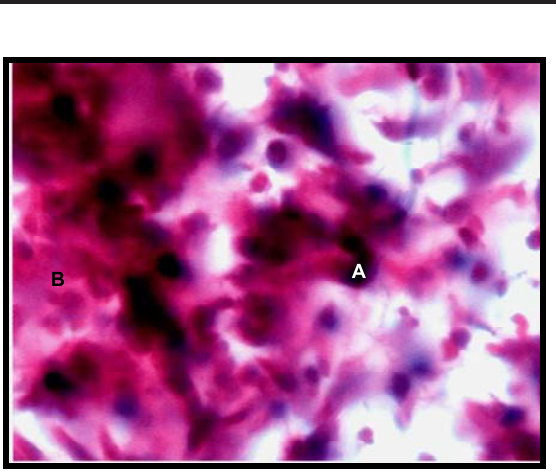
FIGURA 10 – Fotomicrografia de lâmina de um animal do grupo GE3D. NOTA: Lâmina corada pela HE mostrando in - flamação crônica moderada (A –